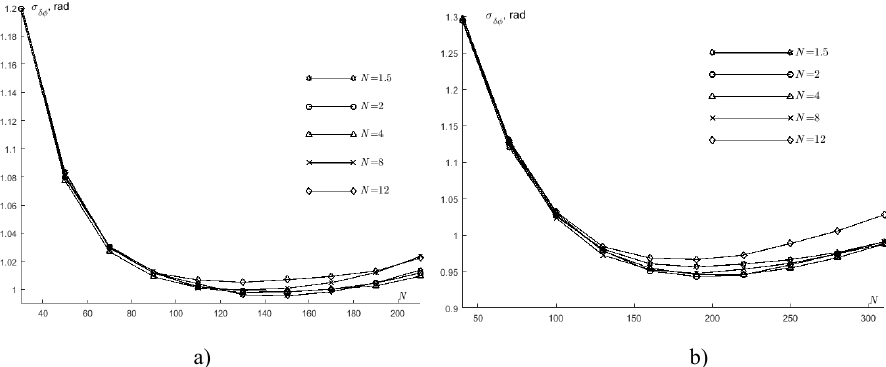
 dependencies on the cutoff frequency (pix) for spectral Gaussian filter: a) scene N 1; b) Fig. 4.  scene N 5. Table 2. Optimal filteration algorithms